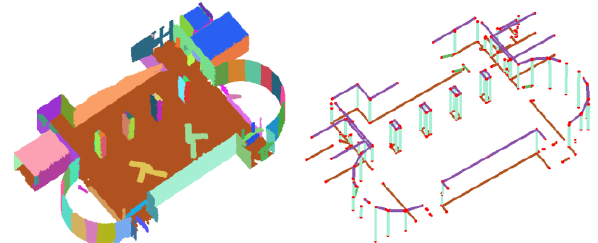
Figure 5. Left: surface patches from generalization process. Right: intersection lines between pair surfaces. For simplicity of figures, we chose an area with minimal clutter. The data is acquired by a trolley system.